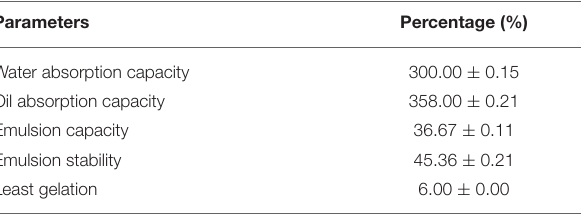
TABLE 2 | Functional properties of C. forda